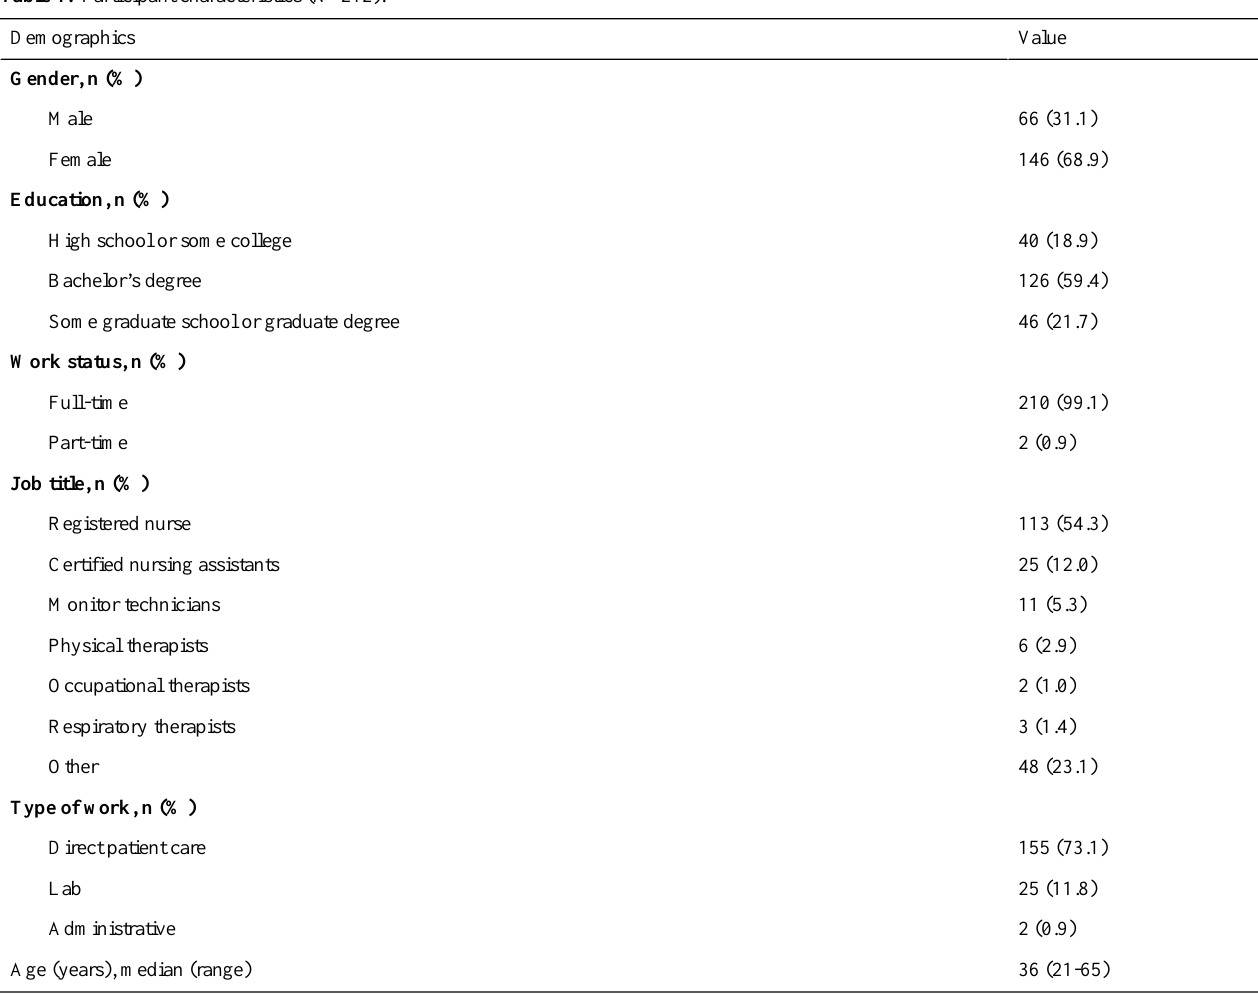
Table 1. Participant characteristics